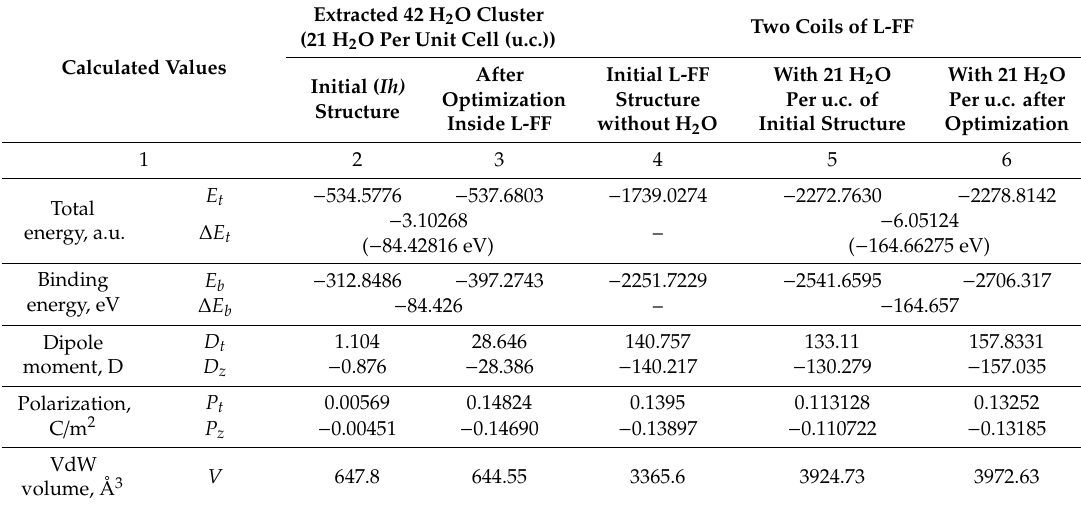
Table 4. Energy, dipole moment and polarization of L-FF PNTs and water clusters, computed